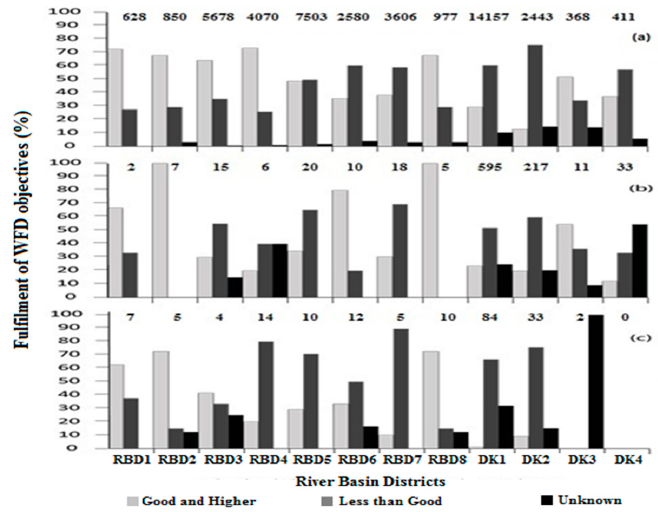
Figure 6. Overall status of ( a ) rivers, ( b ) lakes/reservoirs and ( c ) coastal/transitional waters in the 8 Portuguese and 4 Danish River Basin Districts (RBD/DK). Values above columns refer to the length of rivers (km), number of lakes/reservoirs and coastal/transitional waters for ( a ), ( b ) and ( c ), respectively [6,32]. respectively